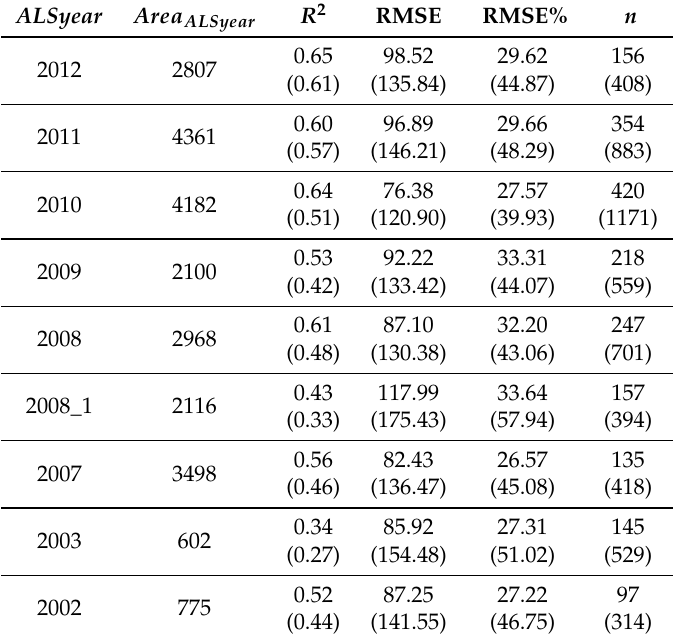
Table 5. R 2 , RMSE and RMSE% on the cluster level of the full regression model within ALS acquisition year strata ( ALSyear ). Area ALSyear : Area covered by ALS acquisition given in km 2 . n : sample size of validation data. () give the respective values on the plot